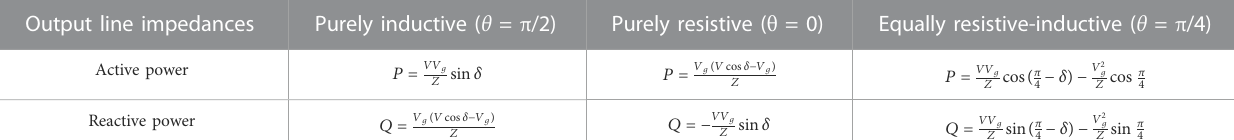
TABLE 2 Simpli fi ed power model under different line impedance characteristics.